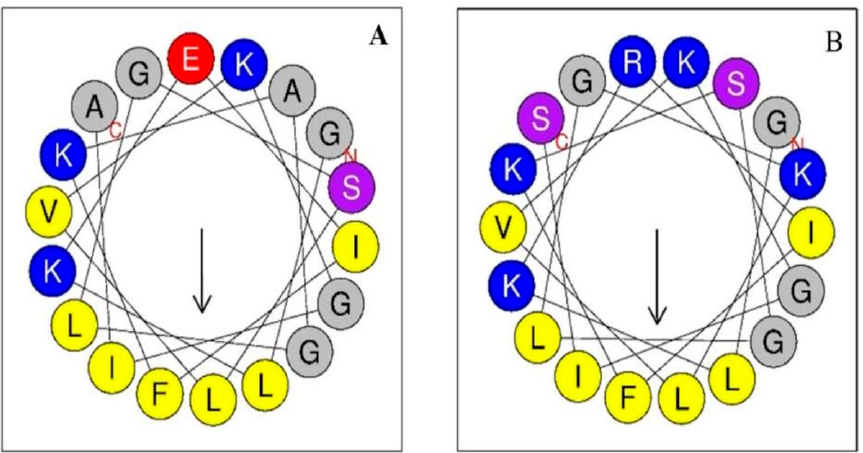
Figure 1. Wheel projections of the first 18 residues of the sequence of each peptide. Alyteserin-1c peptide ( + 2) ( A ); peptide + 5 ( B ). The hydrophobic amino acids are yellow, and the charged amino acids are blue (positive charge) or red (negative charge). The polar amino acids are purple and those in between are grey.